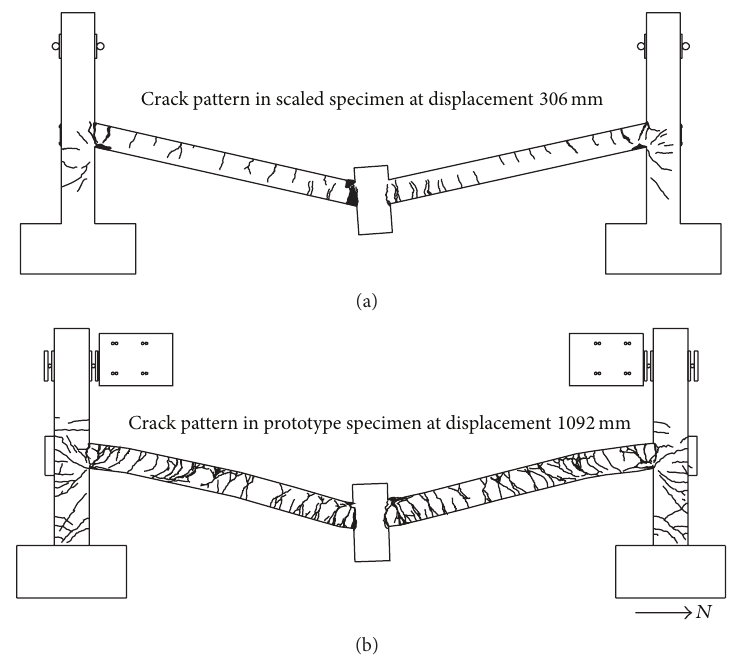
Figure 9: Comparison of crack pattern in full-scale and scaled specimens at the end of tests.